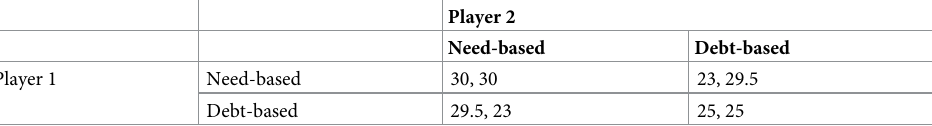
Table 1. Risk pooling norms as a Stag Hunt Game. In a computer simulation (Aktipis et al. 2016), need-based vs. debt-based strategies correspond to a Stag Hunt Game, with need-based transfers being dominant to debt-based trans- fers. Payoffs in this game theoretic matrix are given in percent of agents surviving at 50 years. Both players get the high- est payoff if they both choose need-based